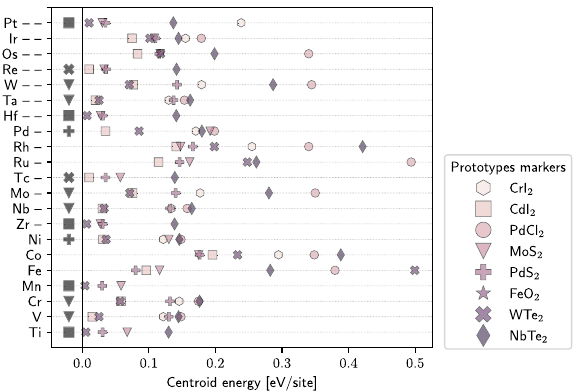
Fig. 5 Polymorphism of TMDs. Minimum centroid energy, x -axis, of all non-GS prototypes for each TM, y -axis. The legend on the right reports marker and colour associated with each prototype. Black marks left of x = 0 line show the 2D GS prototype of the